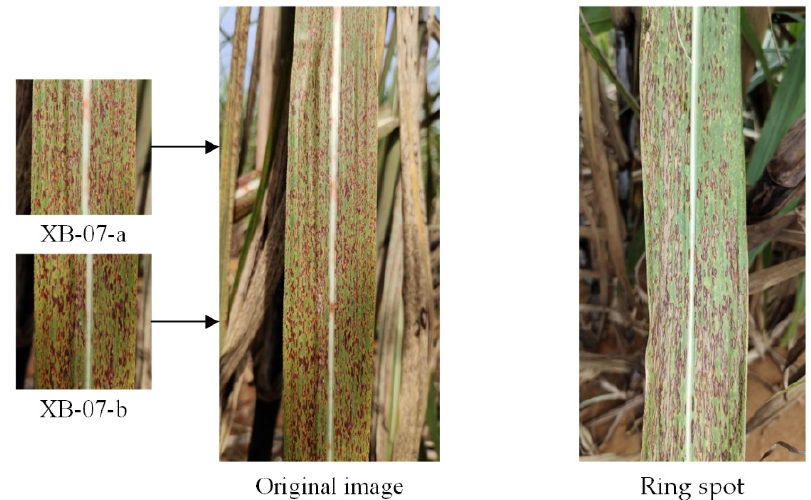
Figure 13. Comparison of pictures of misclassified rust and ring spots.